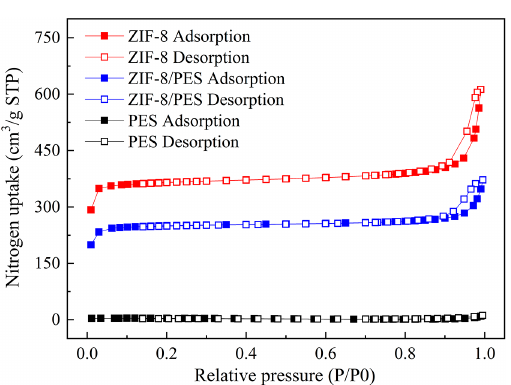
Figure 7. Nitrogen adsorption − desorption isotherms at 77 K for nanosized ZIF-8, PES, and nanosized ZIF-8 / PES composites. For composites, the solvent was DMF, and the ZIF-8 loading was 60 wt.%.